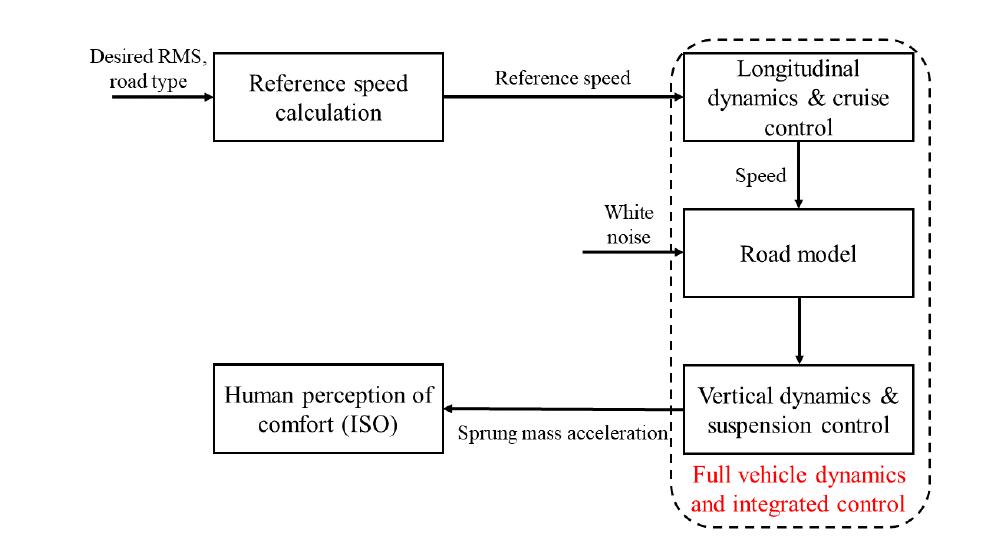
Figure 17. Simulation scheme.